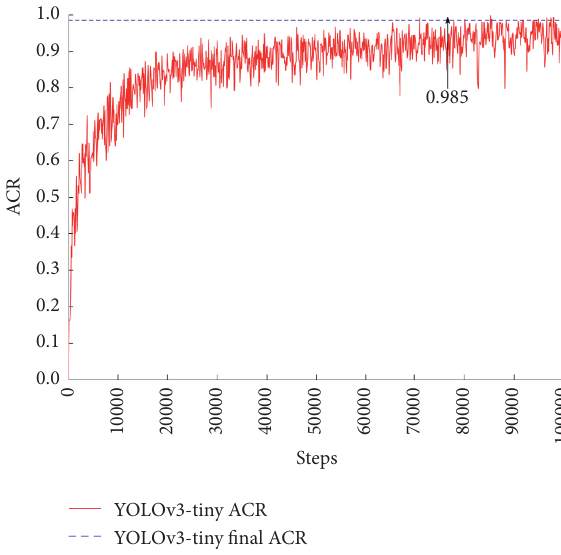
Figure 15: Driver face detection accuracy.